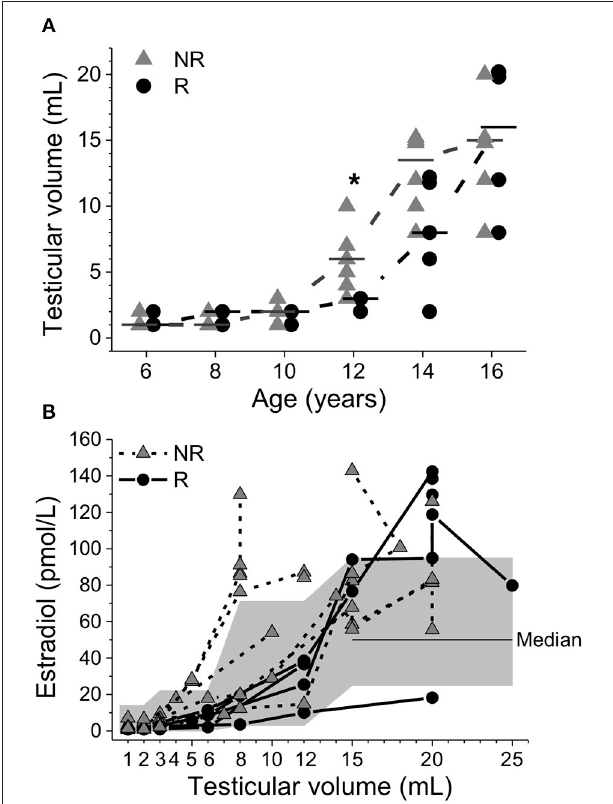
FIGURE 4 | Testicular volume plotted relative to age (A) . Median values were calculated and denoted as a line for each group and age. Triangles represent non-responders (NR) and circles represent responders (R). Differences between groups are shown as * p < 0.05. Serum estradiol concentrations plotted relative to testicular volume (B) . The gray area depicts reference intervals for healthy boys during pubertal development (